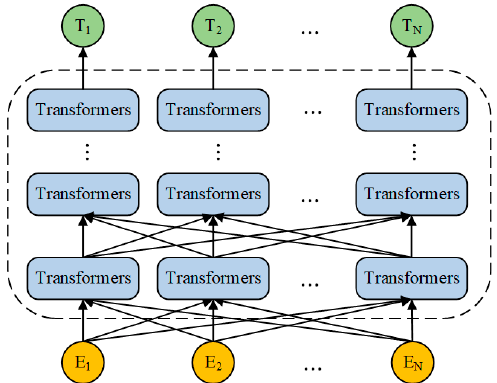
Figure 1. ALBERT model.